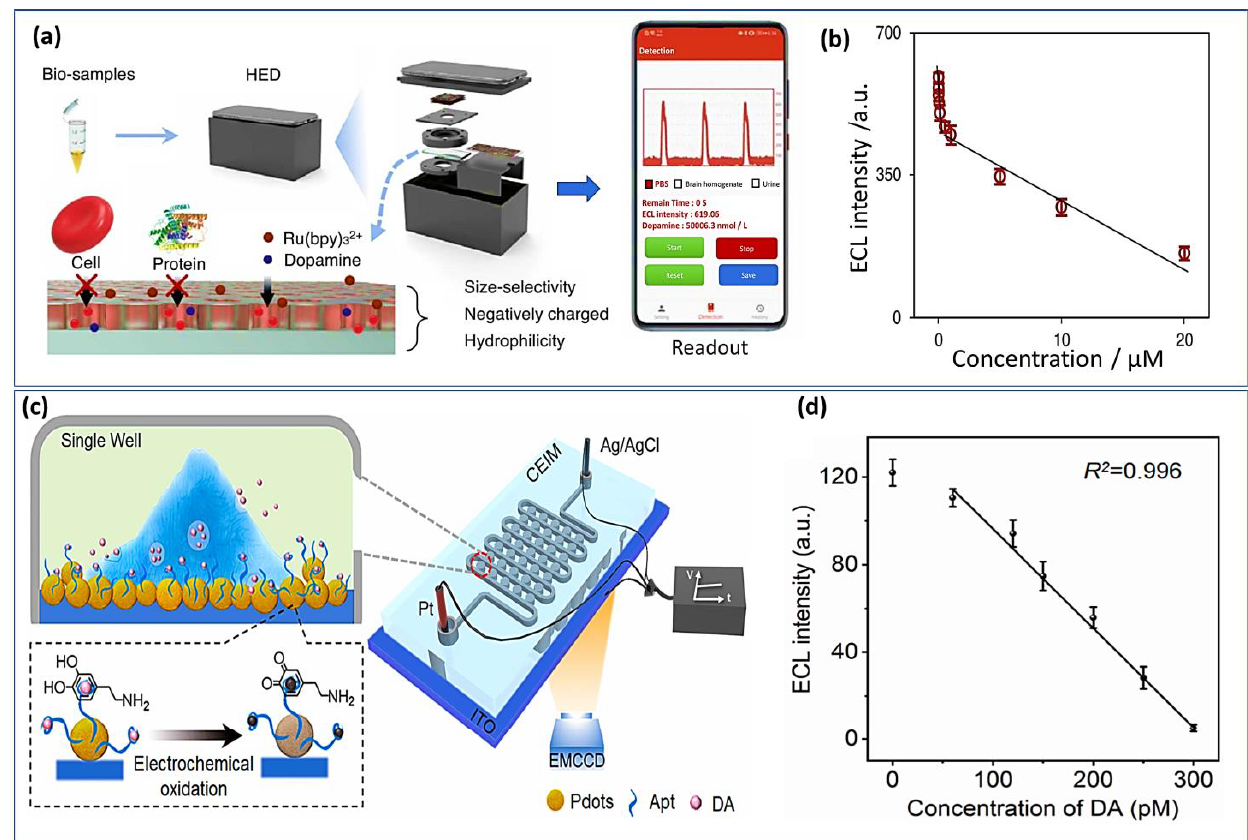
Figure 10. Handheld ELC imaging systems: ( a ) Schematic representation of a handheld ECL analysis device displays the pretreatment and testing of dopamine biosamples, ( b ) Correlation between ECL intensity and DA concentration. Reproduced with permission from [198]. Copyright 2023, Elsevier. ( c ) Experimental setup of confined ECL imaging chip (CEIM) for sensing DA released from a single PC12 cell, ( d ) Calibration curve ECL signal as a function of the DA concentrations. Reproduced